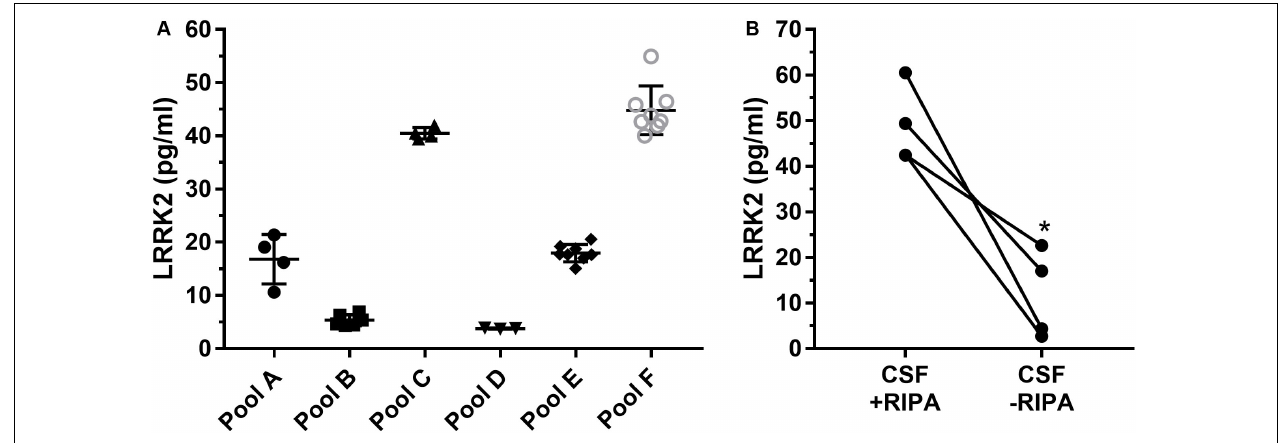
FIGURE 3 | Remnant CSF samples were pooled (A–F) and then split into separate 1 ml aliquots. Samples were then processed in parallel to determine run to run variability (A) . Overall variability was limited to 12% across pools A–F. Addition of radioimmunoprecipitationassay (RIPA) buffer which contains detergents greatly enhances signal of LRRK2 in CSF (B) . ∗ p <